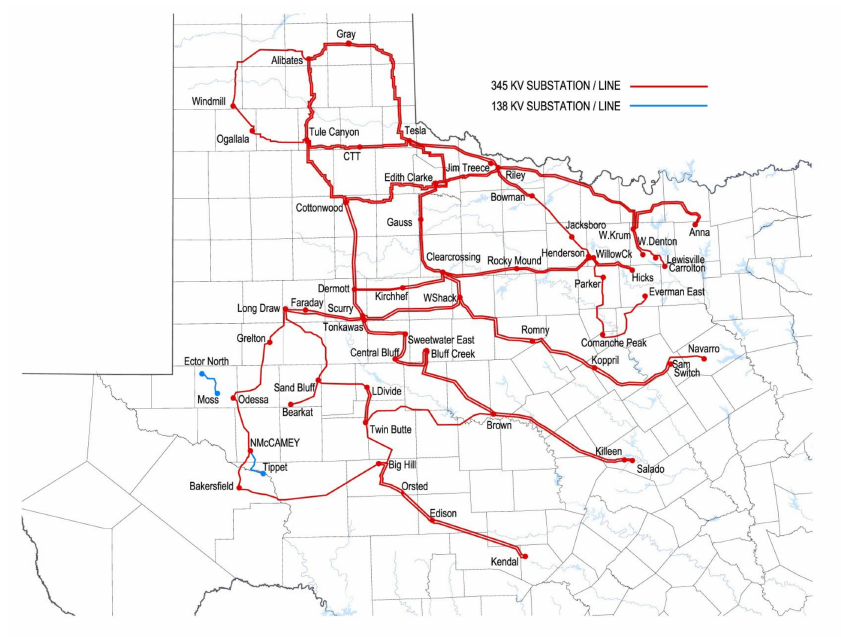
Figure A2. Completed CREZ reinforcement [11].